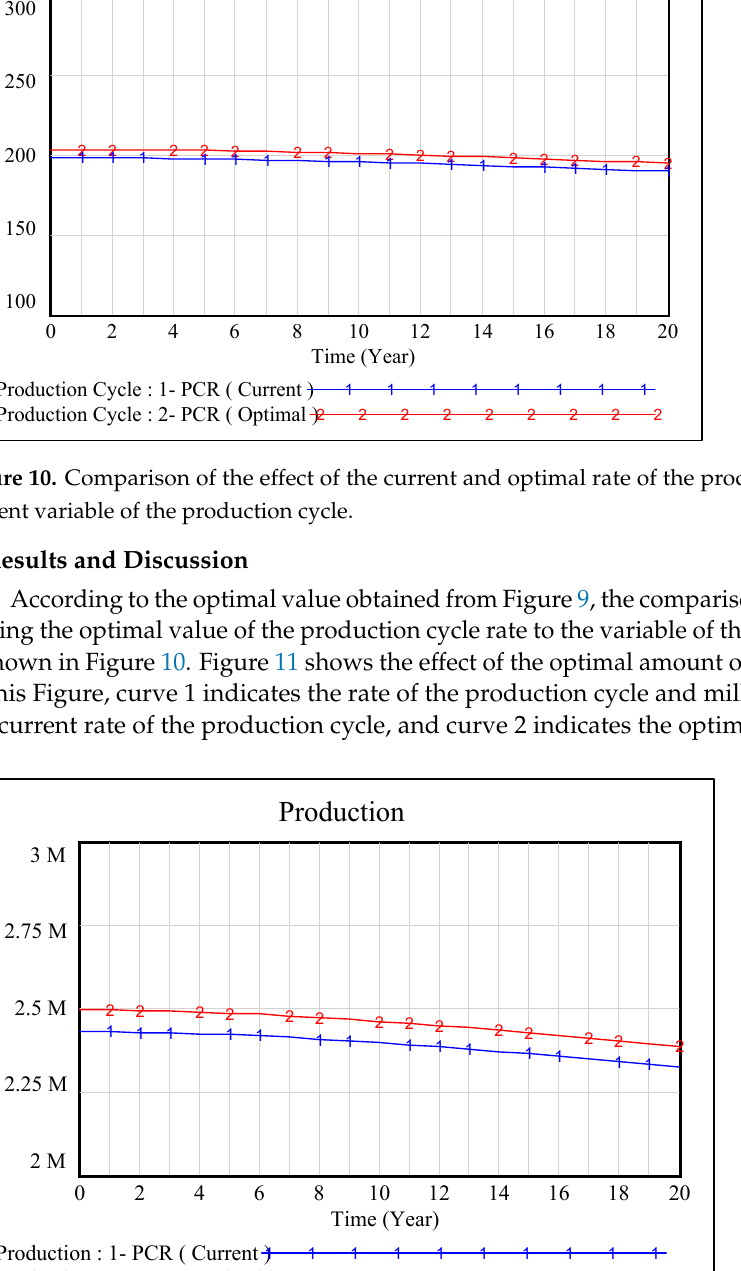
Figure 11. Comparison of the effect of the current and optimal rate of the production cycle on the milk production.